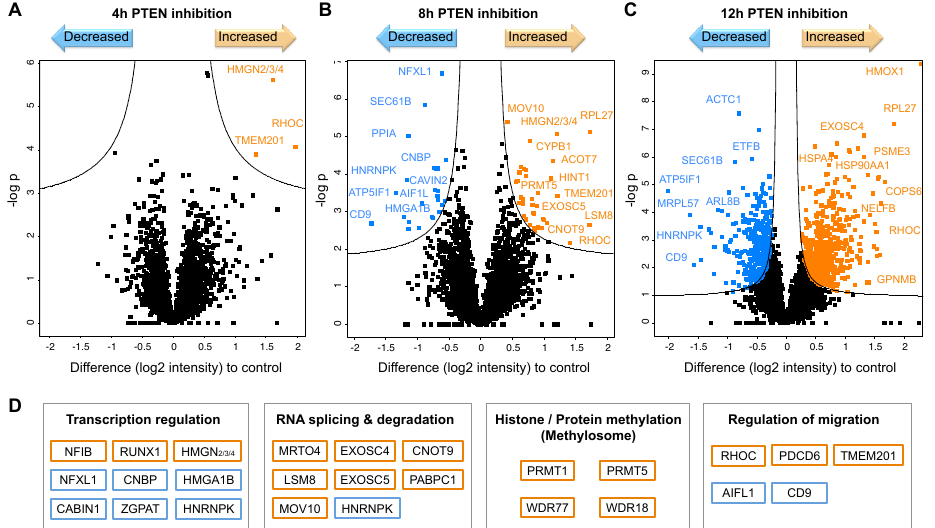
Figure 6. Protein expression changes upon PTEN inhibition in polarized MDCK cells indicate a massive cellular reorganization. ( A – C ) Label-free quantification of the cellular proteotype over a time course of PTEN inhibition by 1 µ M SF1670 for 4 h, 8 h, and 12 h. ( D ) Functional classes of selected proteins that were found to have an altered abundance after 8 h of PTEN inhibition as potential drivers of proteotype reorganization. Proteins with a significantly altered abundance compared with the control are marked in orange (increased) and blue (decreased) ( n = 6, two-sided t -test FDR = 0.05, s0 =